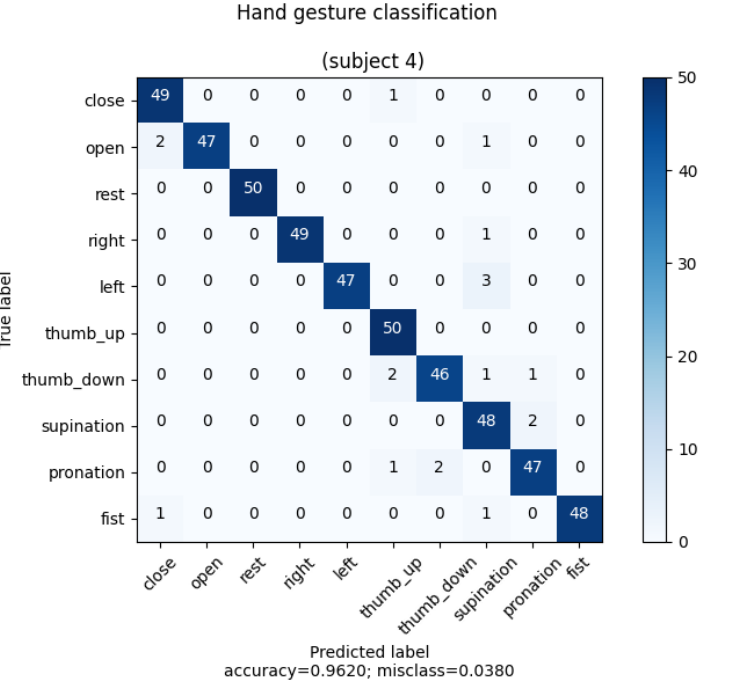
Figure A3. Confusion matrix of a subject who participated in data collection (subject 3).